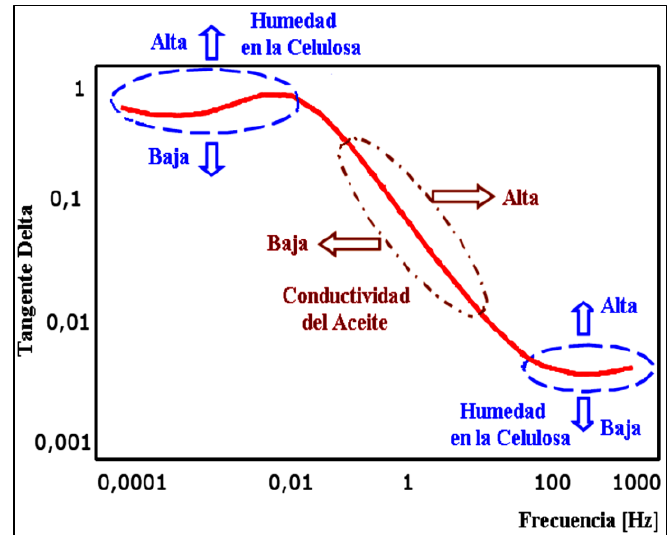
Figura 16: Influencia de las propiedades del papel y el aceite. Fuente: Autores,